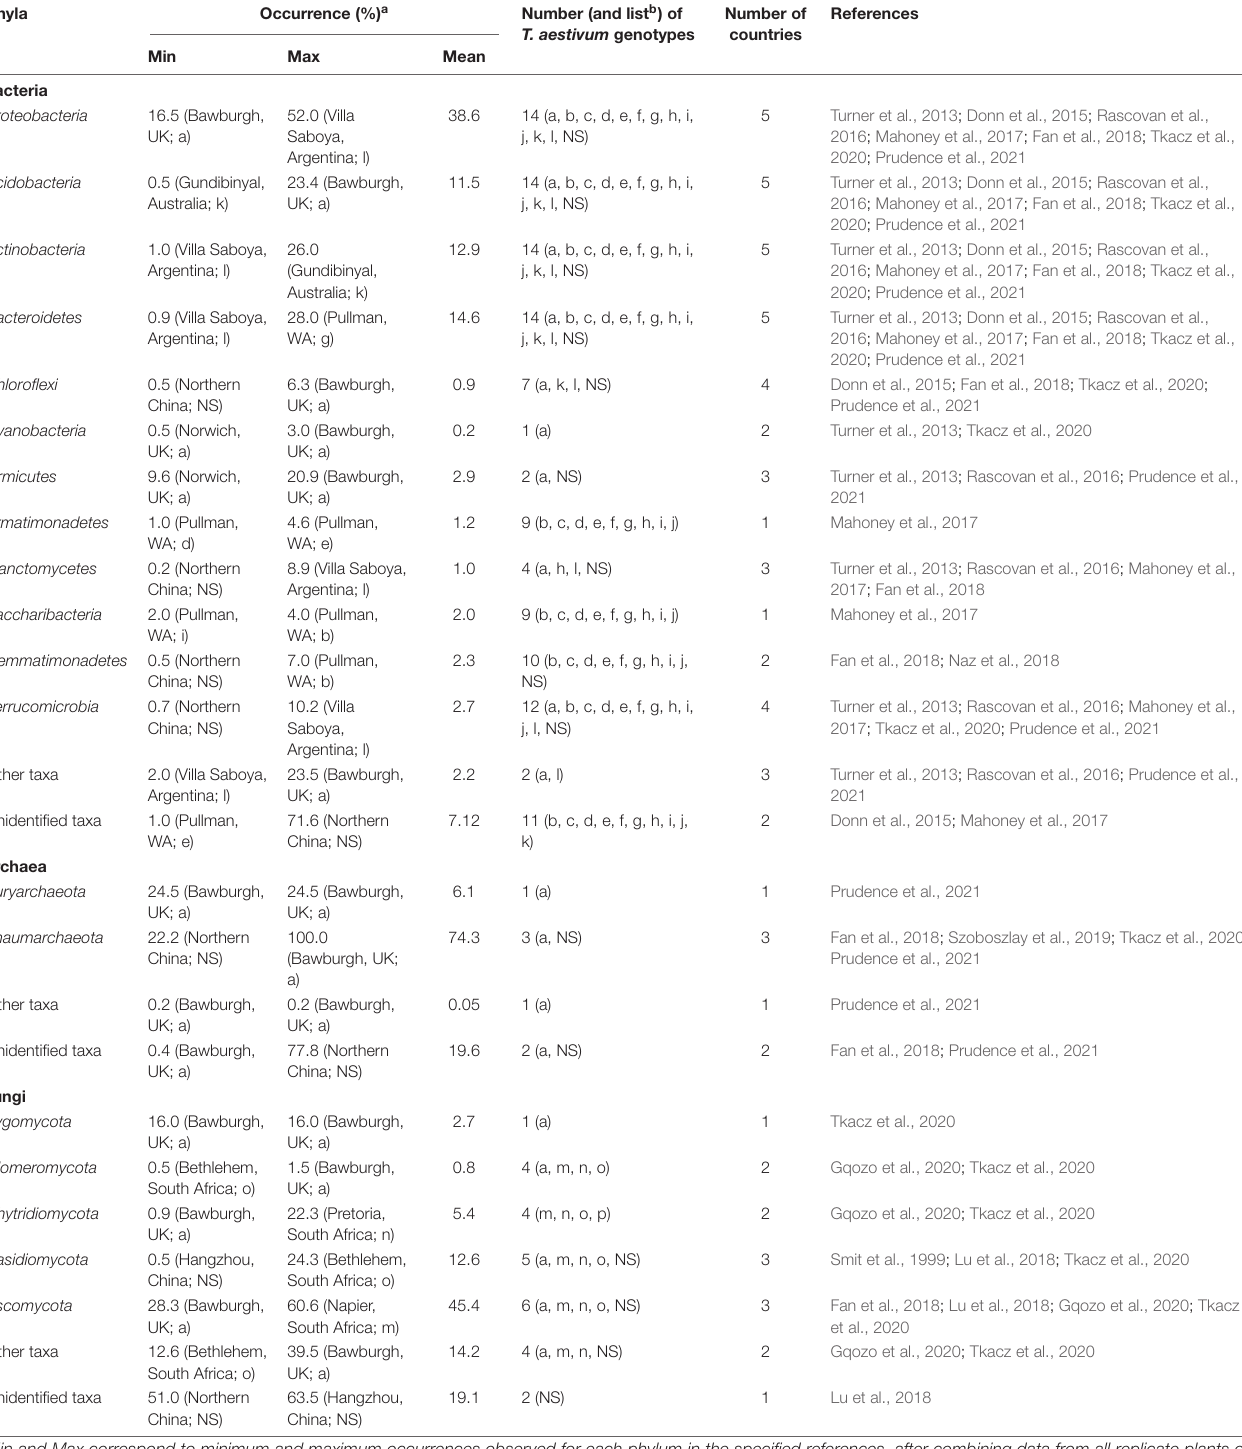
TABLE 1 | Occurrence of phyla in the rhizosphere of T. aestivum , as documented by culture-independent methods. Phyla Occurrence (%)